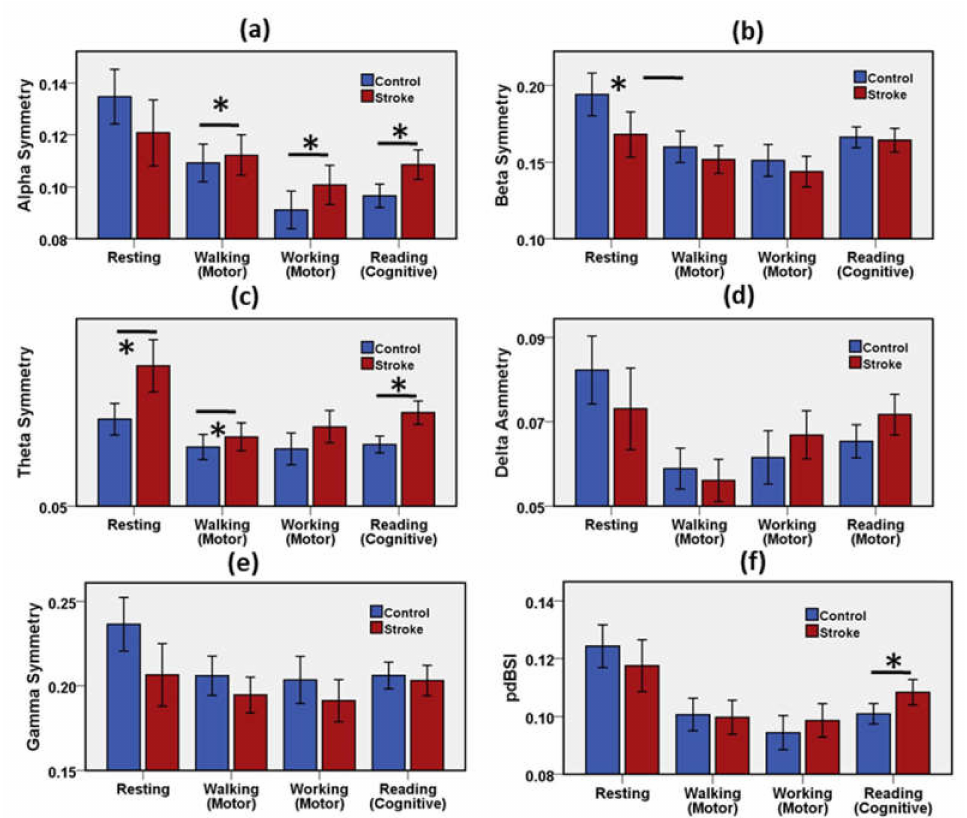
Figure 5. Mean and error bar of ( a ) Alpha asymmetry, ( b ) Beta asymmetry ( c ) Theta asymmetry, ( d ) Delta asymmetry ( e ) Gamma asymmetry, ( f ) pdBSI of the stroke group and the control group during resting, motor, and cognitive tasks. Error bar shows 95% confidence interval. * ( p < 0.05) indicates a significant